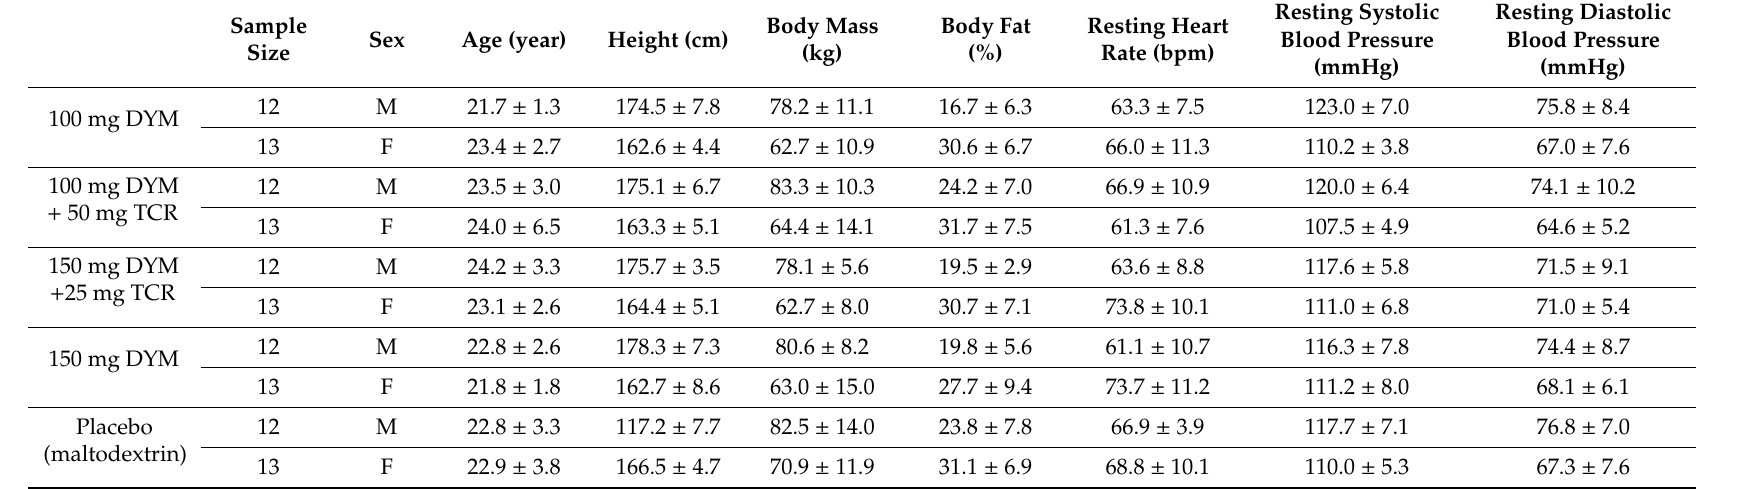
Table 1. Baseline participant descriptions. Values are means ± SD. M—male;